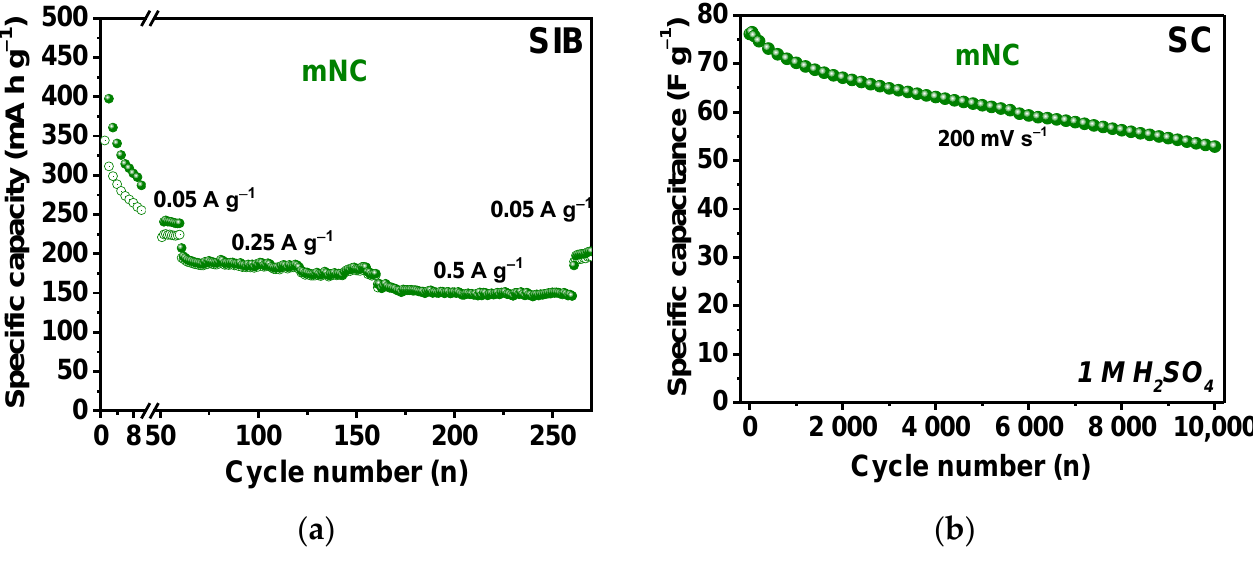
Figure 6. Long-term stability measurements of the mNC electrode in ( a ) half-cell SIB at current densities of 0.05, 0.25 and 0.5 A g − 1 for total 270 cycles and ( b ) symmetric SC with 1 M H 2 SO 4 electrolyte at a scan rate of 200 mV s − 1 for 10,000 cycles.